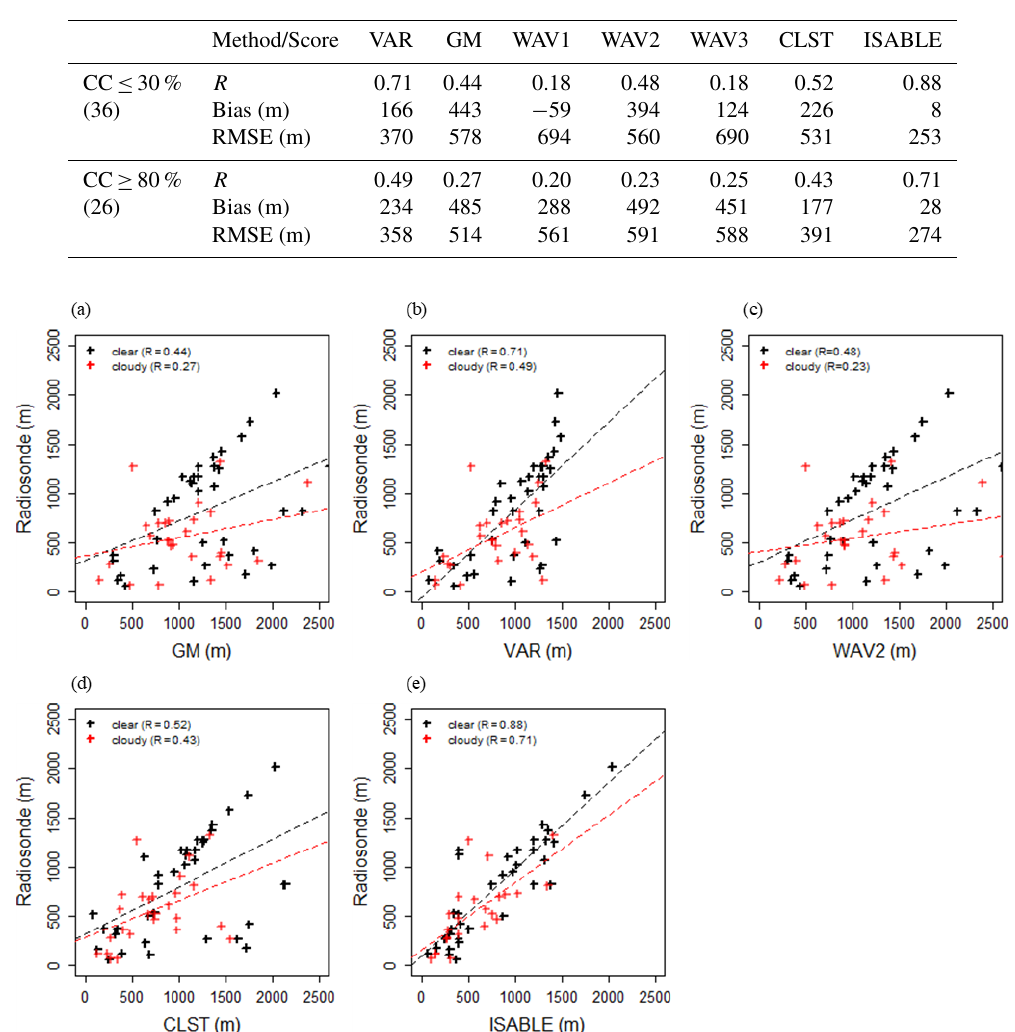
Table 3. Statistical performance between ABLHs obtained by various methods, including ISABLE and radiosonde observations for clear ( N = 36; CC ≤ 30%) and cloudy skies ( N = 26; CC ≥ 80%) for the period from August 2016 to October 2018.